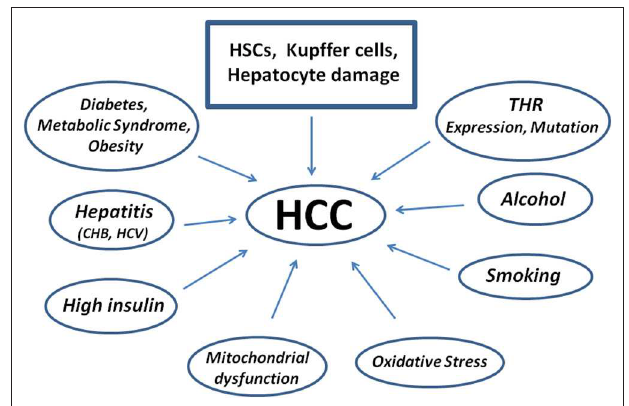
FIGURE 3 | Scheme showing diseases and factors leading to the pathogenesis of Human Hepatocellular Carcinoma starting from Hepatic Stellate Cells damage. Kupffer cells contribute to repair, but may also impair the damage as well as hepatocytes. CHB, Chronic Hepatitis B; HCV, Hepatitis C